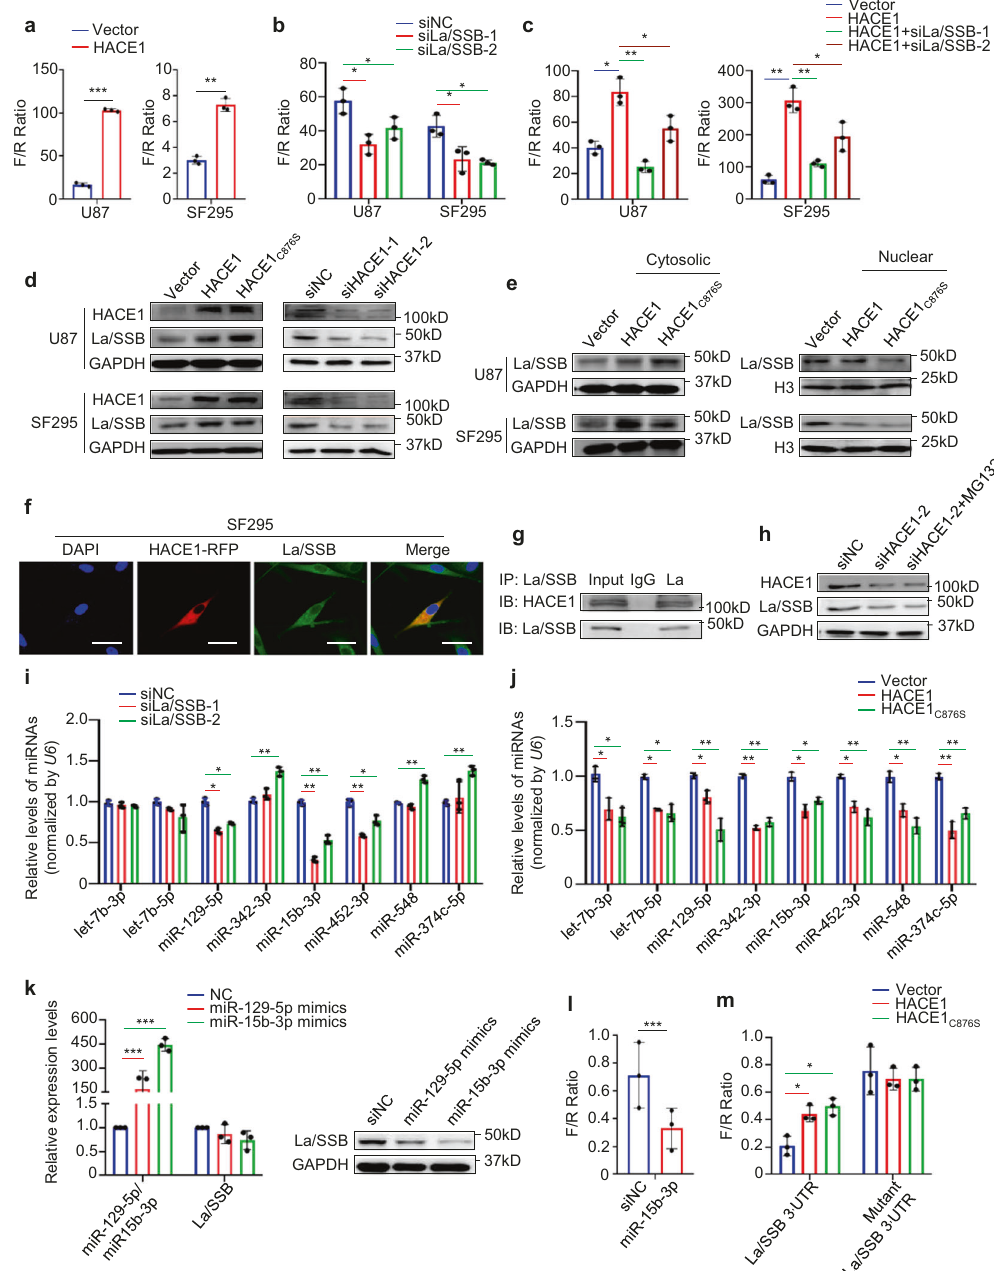
Fig. 5 HACE1 enhances IRES-mediated translation of NRF2. a , b The IRES activity of NRF2 was detected by the dual-luciferase reporter system in HACE1 overexpression- or La/SSB knockdown-SF295 and U87 cells and control cells. c La/SSB was knocked down on the basis of ectopic expression of HACE1. The IRES activity of NRF2 was then assessed by the dual-luciferase reporter system. d Western blot analysis of HACE1, La/ SSB, and GAPDH (loading control) in HACE1/HACE1 C876S overexpression- or HACE1 knockdown-SF295 and U87 cells, and control cells. e Western blot analysis of La/SSB, GAPDH (loading control for cytosolic proteins), and histone H3 (loading control for nuclear proteins) in cytosolic and nuclear fractions of HACE1/HACE1 C876S overexpression-U87 and SF295 cells and control cells. f Immuno fl uorescence assay showing the co-localization of HACE1 and La/SSB in the extranuclear region of SF295 cells. Blue color represents DAPI staining for nuclei; red color represents HACE1 tagged with RFP; Green color represents La/SSB. Scale bars, 20 μ m. g Co-IP assay showing the interaction of HACE1 and La/SSB in SF295 cells. h HACE1 knockdown-SF295 cells and control cells were pretreated with 25 µM MG132 or DMSO for 4 h, and then subjected to western blot analysis using the indicated antibodies. i, j qRT-PCR assay of the indicated miRNAs in the La/SSB knockdown-, or HACE1/HACE1 C876S overexpression-SF295 cells and control cells. k The impacts of miR-129-5p and miR-15b mimics on La/SSB expression at mRNA or protein levels were assessed by qRT-PCR and western blot assays in SF295 cells. U6 and GAPDH were used as the normalized controls, respectively. l The effect of miR-15b mimic on La/SSB 3 ′ -UTR activity was evaluated by the dual-luciferase reporter system. m Wild- type or mutant La/SSB 3 ′ -UTR activity was evaluated by the dual-luciferase reporter system in HACE1/HACE1 C876S overexpression-SF295 cells and control cells. Data were expressed as mean ± SD. * P < 0.05; ** P < 0.01; *** P <